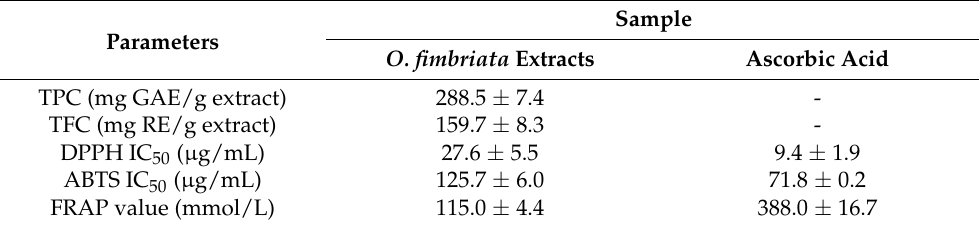
Table 1. Antioxidant content and antioxidant activity of Orostachys fimbriata extracts. Parameters